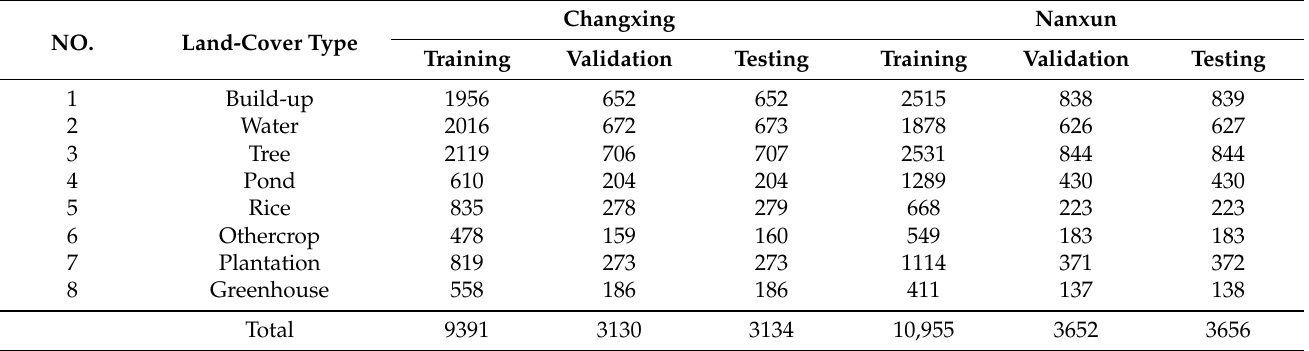
Table 1. Comparison of the classification results of different classification methods on the study area 2021